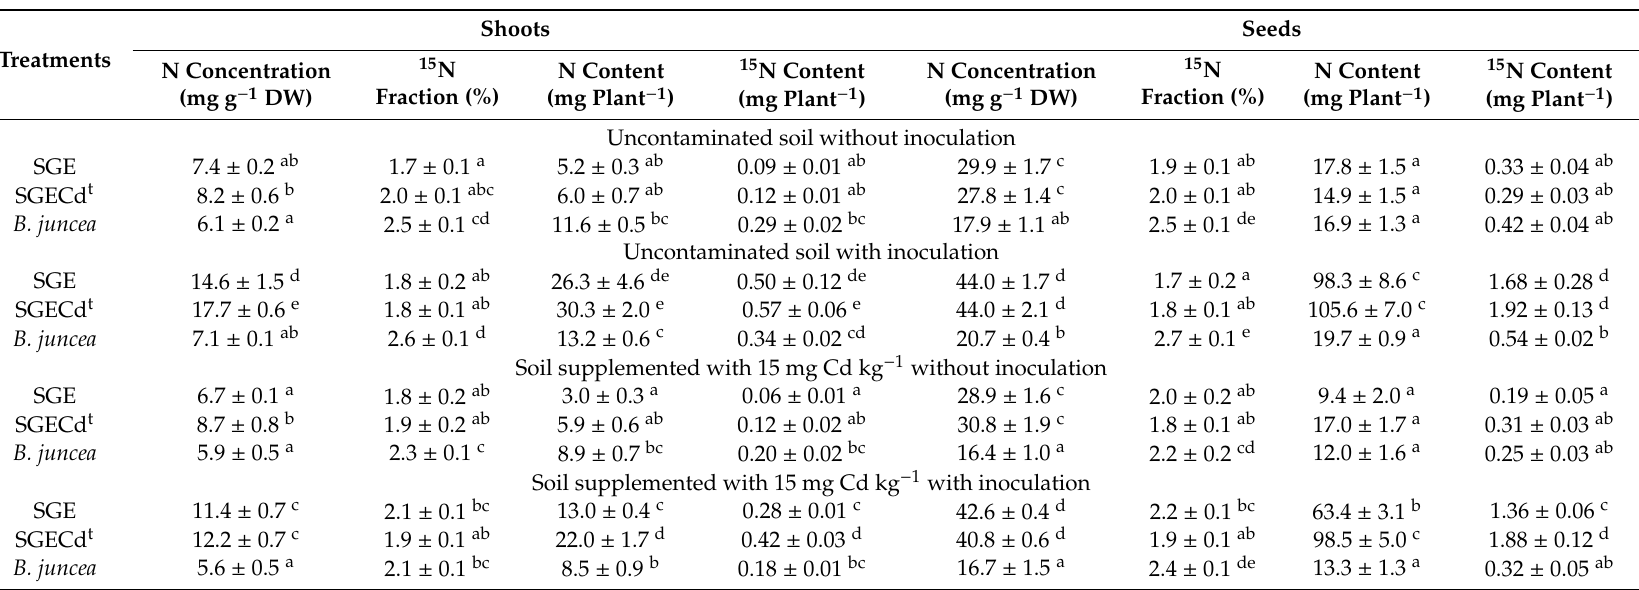
Plants were inoculated with a microbial consortium consisting of Variovorax paradoxus 5C-2, Rhizobium leguminosarum bv. viciae RCAM1066, and Glomus sp. 1Fo. Di ff erent superscript letters (a, b, c, d and e) show significant di ff erences between treatments within a column (least significant di ff erence test, p < 0.05, n = 5). Di ff erent letters (a, b and c) show significant di ff erences between treatments. Data are means ± SE. Plants were analyzed on the 83rd day after